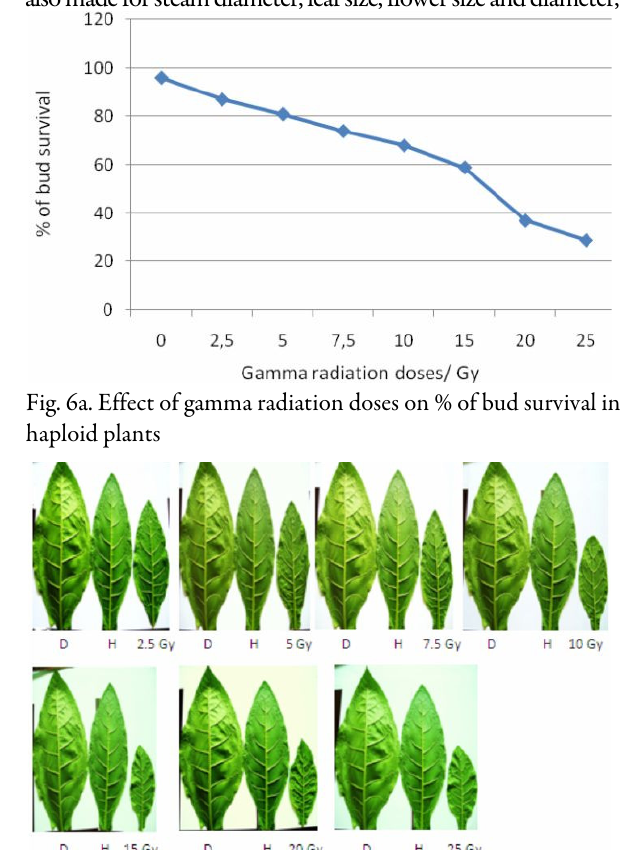
Fig. 7. Effect of gamma radiation doses on proline content in haploid plants